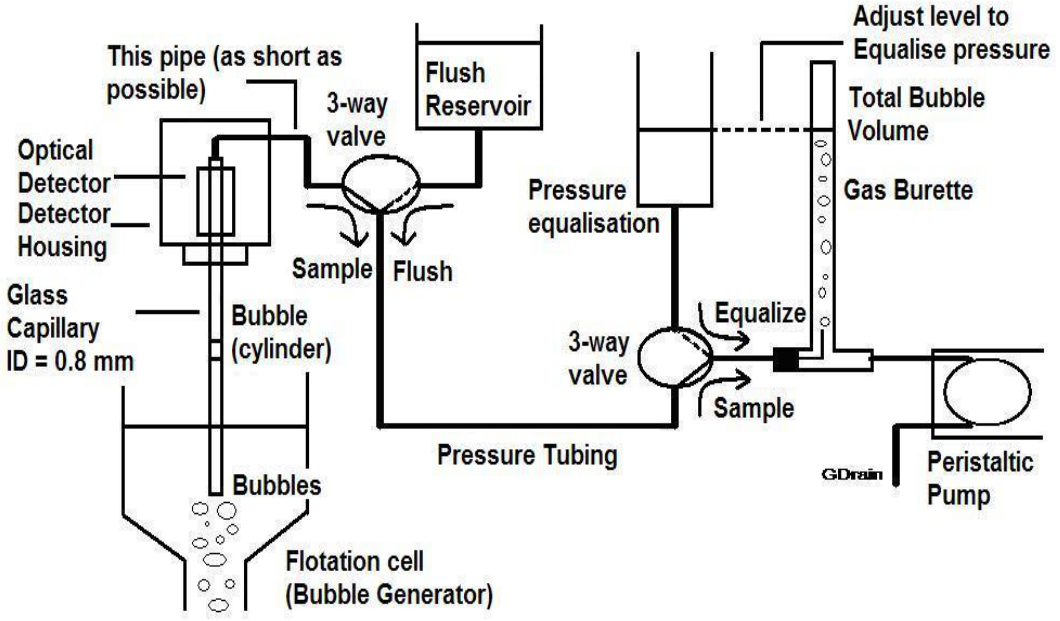
Figure 2. A schematic representation of the UCT bubble size analyser (adapted from the work of Randall et al. [70] and Goodall [71]).